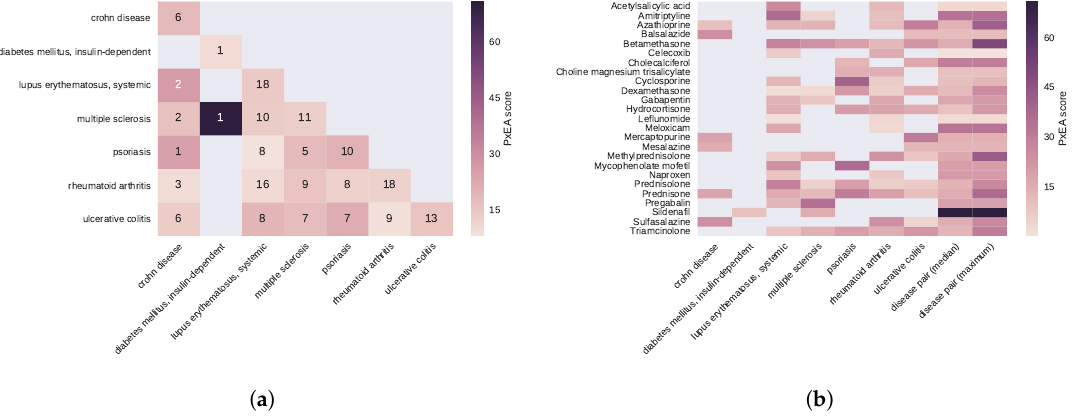
Figure 4. PxEA scores of drugs used in autoimmune disorders. ( a ) Disease-disease heatmap, in which for each disease pair, the common pathways proximal to the two diseases are used to run PxEA. Note that the diagonal contains the PxEA scores obtained when the proximal pathways for only that disease are used. The hue of the color scales with the PxEA score. ( b ) Drug-disease heatmap, in which the PxEA is run using the pathways proximal to the pathways of the disease in the column for the drugs in the rows (25 drugs that are used at least in two diseases). The last two columns show the median and maximum values of the PxEA scores obtained for the drug among all disease pairs the drug is indicated